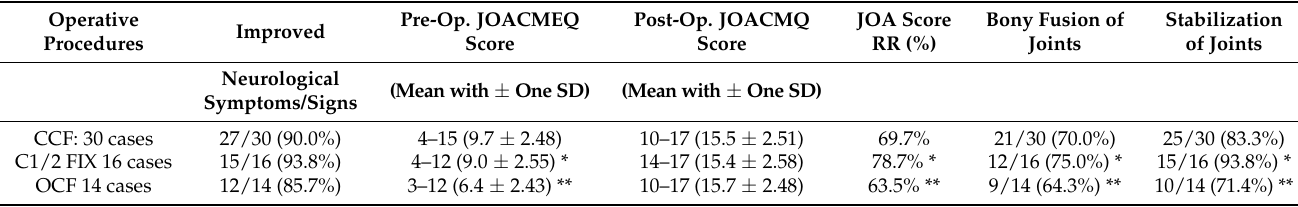
Table 5. JOA score RR after CCF and its